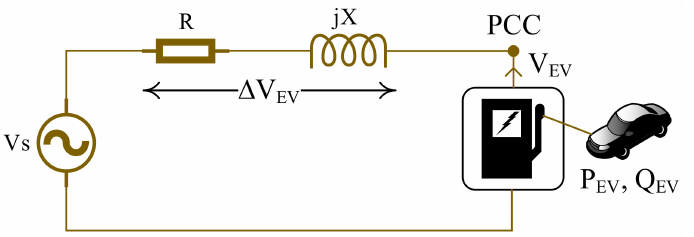
Figure 21. Th é venin equivalent circuit at the point of common coupling (PCC) of the EV system.